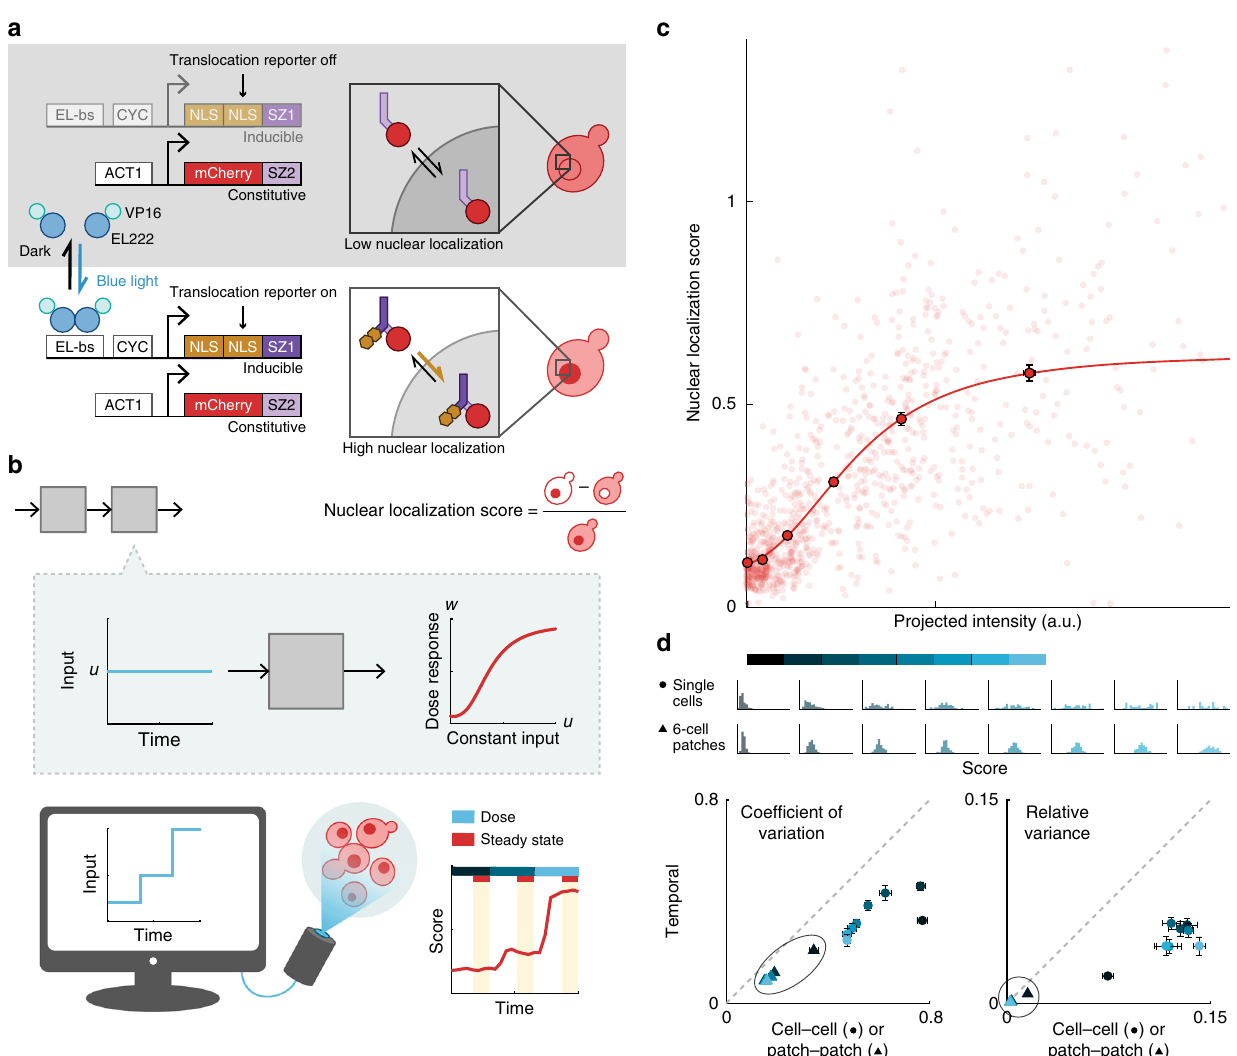
Fig. 3 Experimental characterization of cellular dose response curves shows population-level gradedness. a Blue light induces gene expression in optogenetically responsive Saccharomyces cerevisiae via the VP-EL222 system 36 , as measured by a nuclear translocation reporter (dPSTR) 39 . Cells constitutively express RFP fused to SZ2. In the dark, RFP is distributed equally between nucleus and cytoplasm due to diffusion. Blue light induces VP- EL222 dimerization, which activates expression of an NLS fused to SZ1. SZ1 binds SZ2, such that the NLS promotes localization of RFP in the nucleus, increasing nuclear fl uorescence relative to cytoplasmic fl uorescence. b For a single dose, individual cells were illuminated for 80 min with constant- intensity light. Single-cell responses to a single intensity were calculated as the average score over the last 40 min. Pictured in the schematic are average input intensities and responses for ~700 cells for three consecutive doses. c Although individual cell responses vary, on the population level nuclear localization is graded with respect to the intensity of the light input. Responses of single cells to single doses were pooled across three experiments (no outline). A Hill function was fi t to the quantile means (180 or 181 samples per quantile) to generate the fi nal dose response (solid outline). Source data are provided as a Source Data fi le. d Grouping cells into patches reduces both cell – cell and temporal variability. Scores were binned by projected intensity (blue shaded bar) to generate histograms of score distributions for given input levels (samples per bin left to right: 344, 183, 69, 108, 102, 57, 35, and 26). Bin cutoff is twice the maximum projected intensity used in fi nal patterning experiments. Histograms for 6-cell patches were generated by bootstrapping from individual cell scores within a bin for a total of 200 bootstrapped patches per intensity level. For an ergodic process, cell – cell and temporal variation would be equal (gray dotted line); here, responses appear to be more variable from cell to cell than for single cells across time. Grouping cells into patches of six across which response scores are averaged (triangles) reduces the magnitude of difference between cell – cell or patch – patch and temporal variability. Error bars are